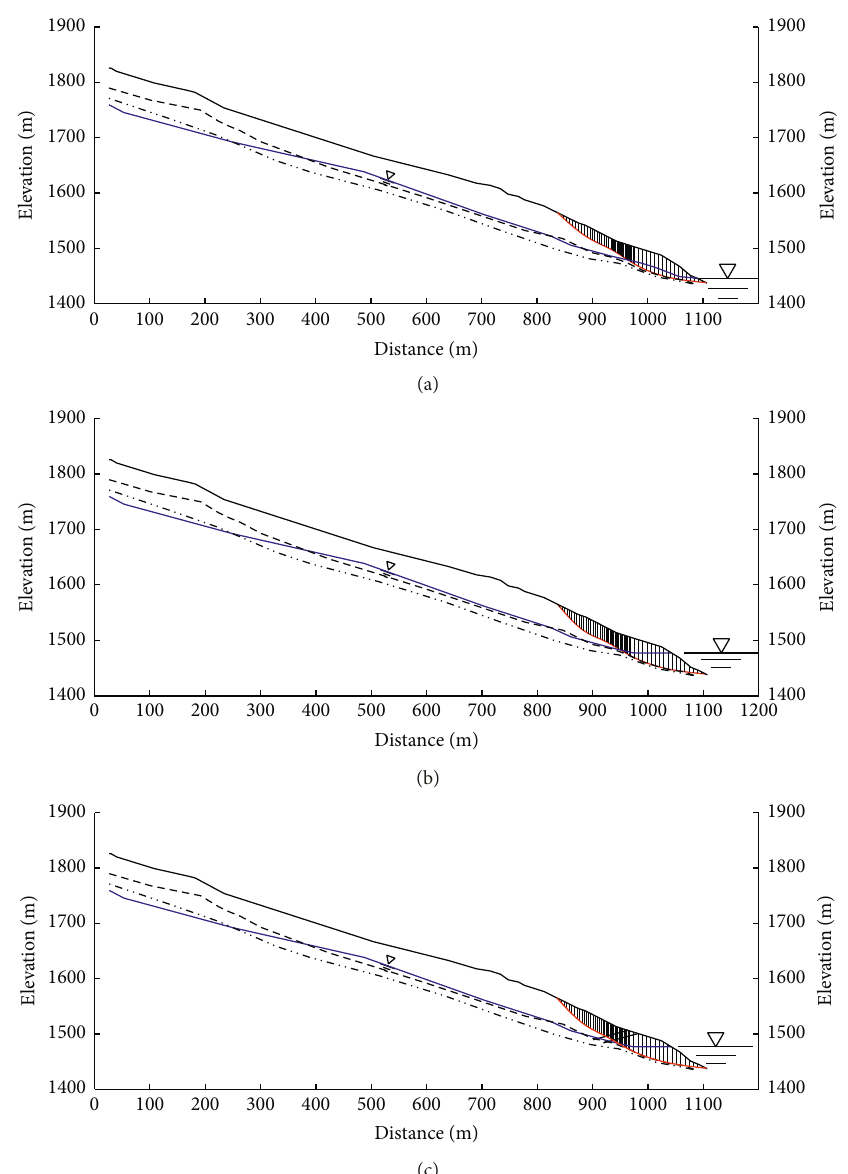
Figure 9: Stability analysis results and diagram of Cangjiangqiao landslide subject to earthquake. (a) Before impoundment. (b) After impoundment without stabilization measures. (c) After impoundment with stabilization